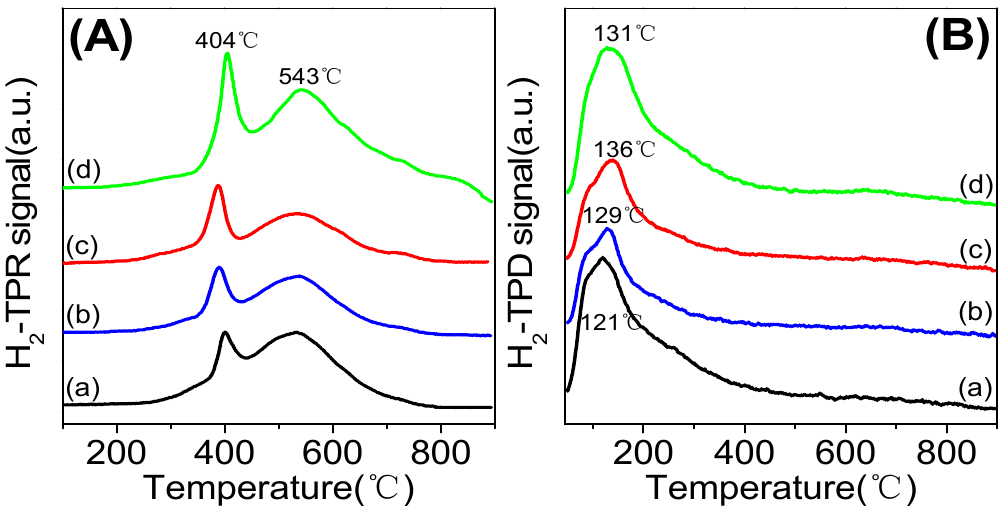
(d) NiMn 2 Al 10 -LDH and ( B ) H 2 -TPD results of the catalysts: (a) NiAl-C, (b) NiMn 0.5 Al 10 -C, (c) NiMn 1 Al 10 -C and (d) NiMn 2 Al 10 -C.